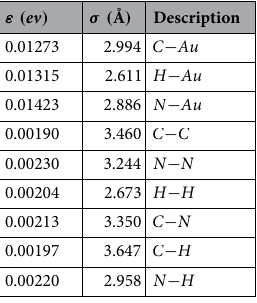
Table 2. Parameters of the Lj potential.